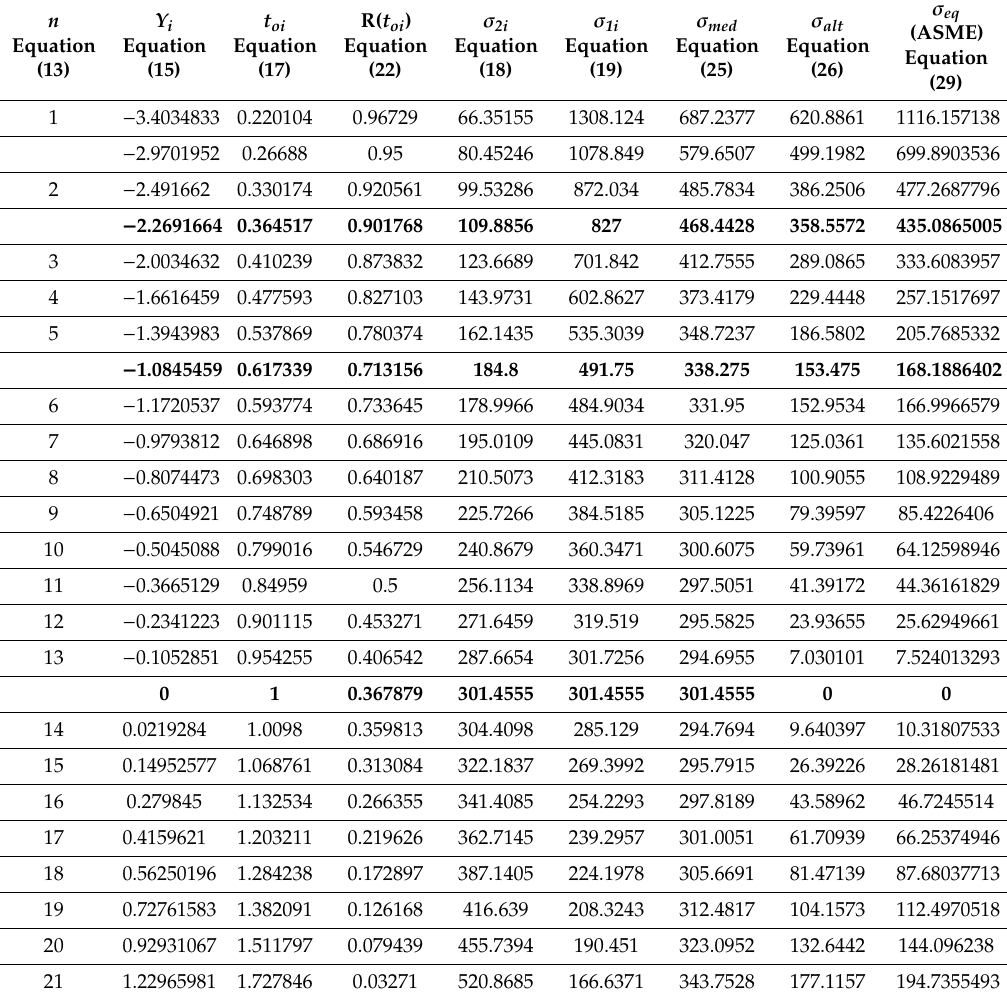
Table 4. Statistics of Weibull FEA stress analysis for data in Section